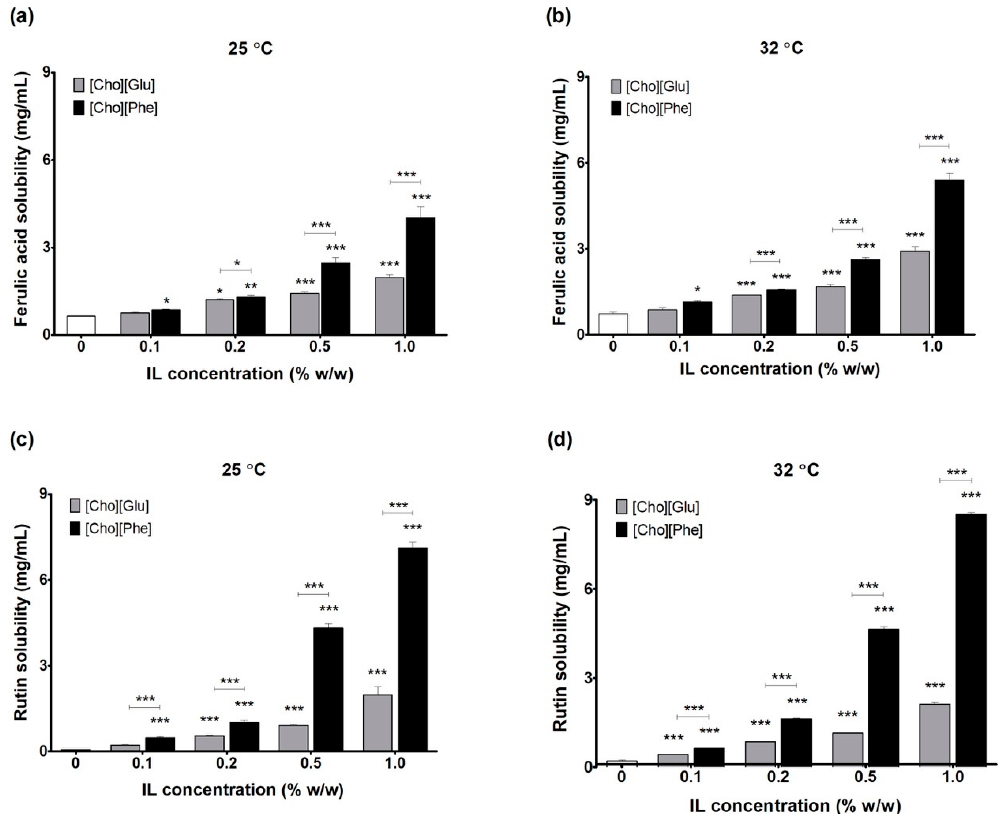
Figure 1. Solubility in water or water:IL mixtures (99.8:0.2%, w/w ) of ferulic acid at 25 ◦ C ( a ) and 32 ◦ C ( b ) and of rutin at 25 ◦ C ( c ) and 32 ◦ C ( d ). n = 3, mean ± SD and * p < 0.05, ** p < 0.01, *** p < 0.001 (one-way ANOVA, Tukey’s test, relative to water solubility).